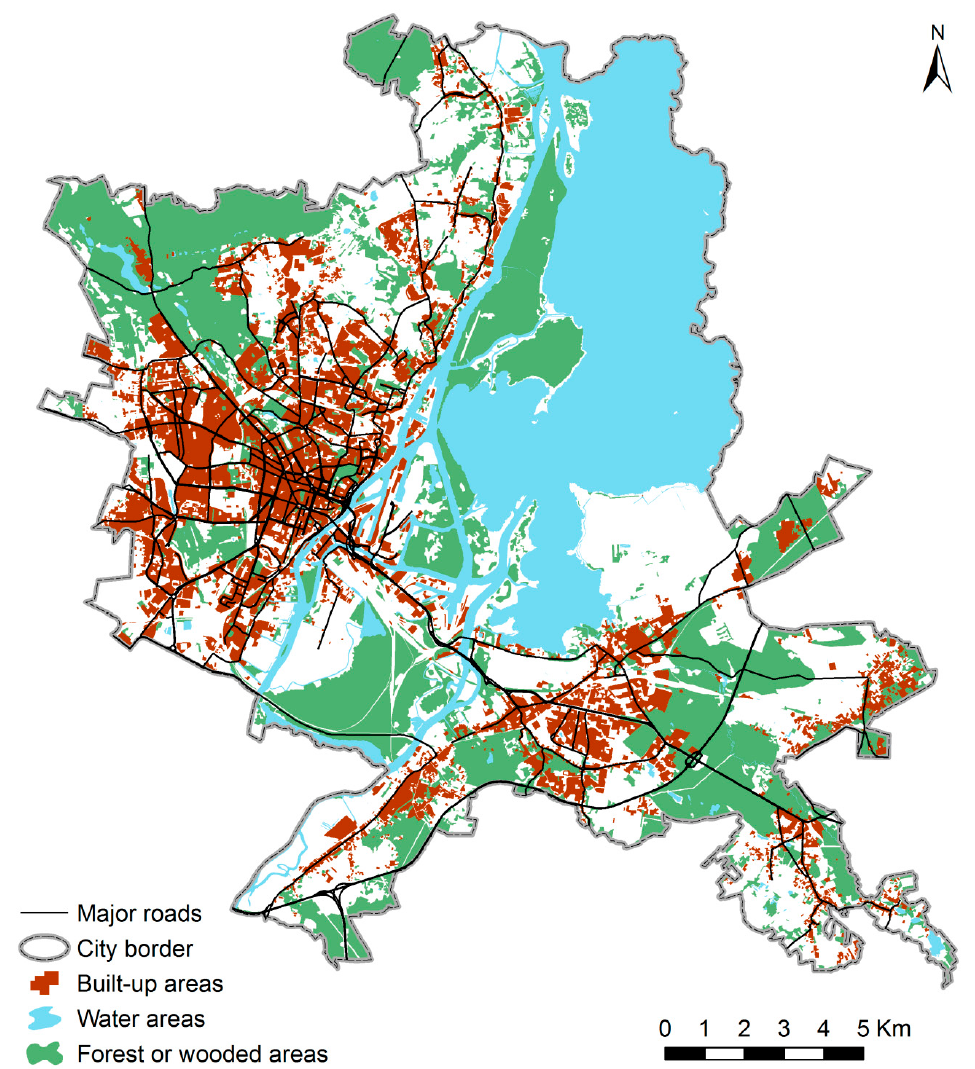
Figure 1. The study area showing the city of Szczecin (Poland). Source: Topographic Geodatabase of the city of Szczecin.